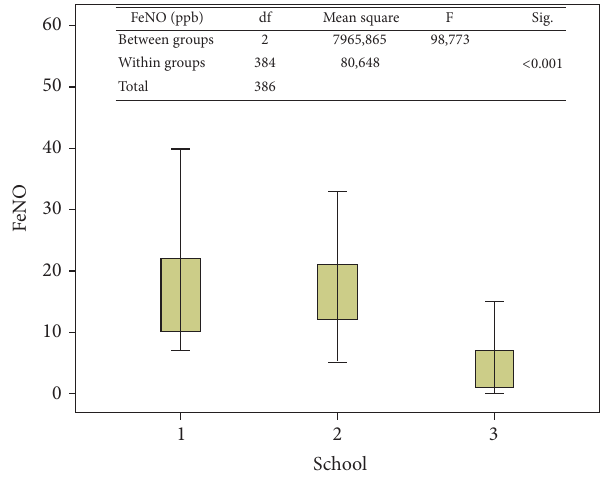
Figure 3: FeNO levels of three